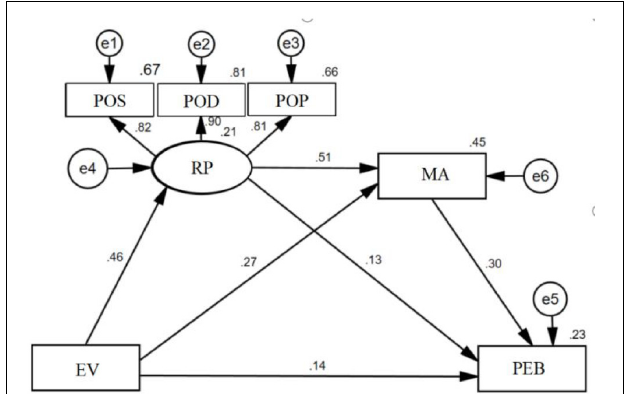
FIGURE 2 | Hypothesis test results.